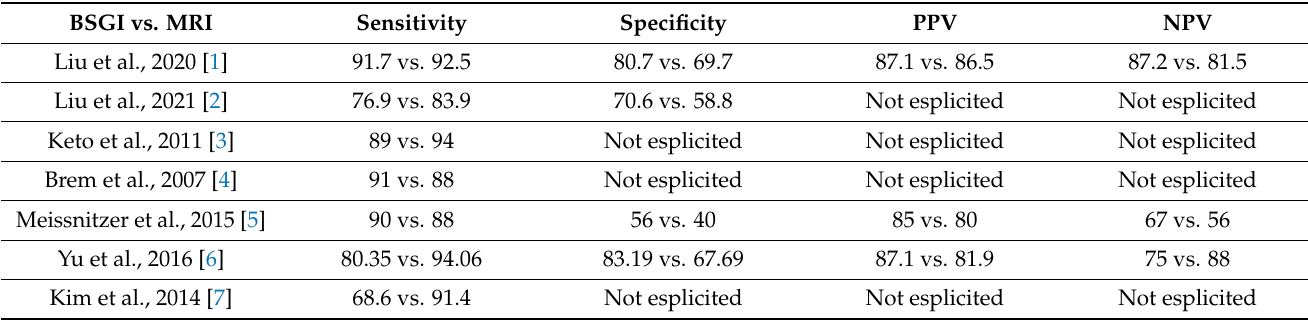
Table 1. A summary of studies that compared BSGI and